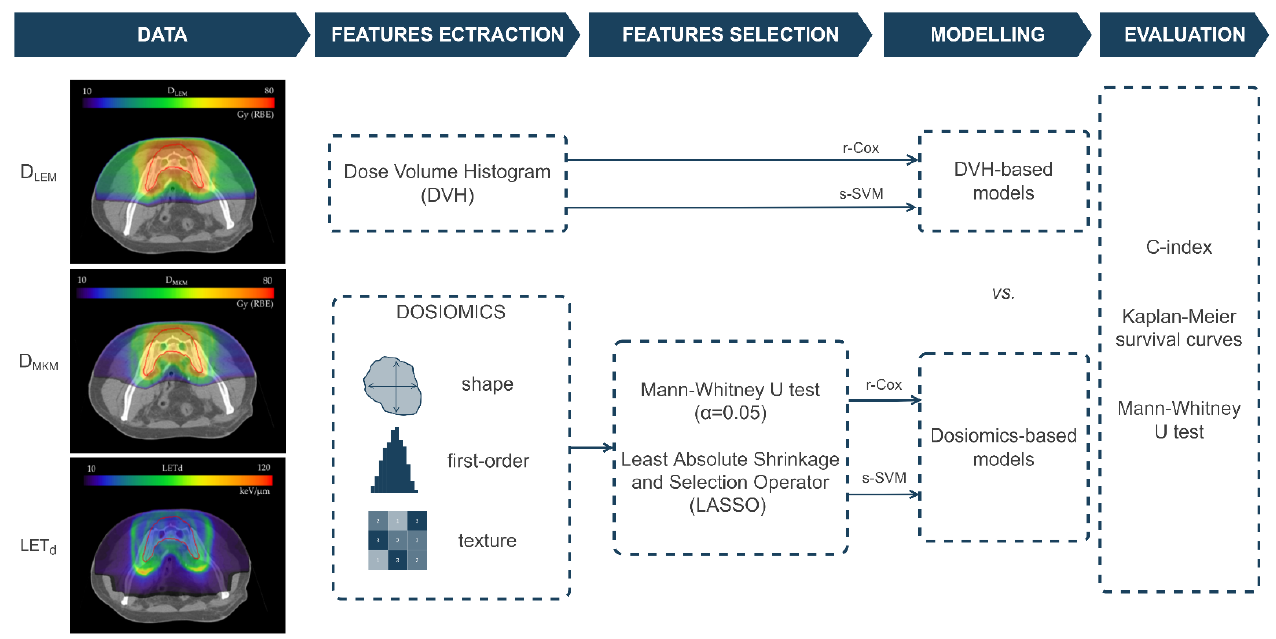
Figure 1. The proposed workflow. Dosimetric parameters and dosiomics features were extracted from D LEM , D MKM and LET d maps. Mann – Whitney U test (MW) and Least Absolute Shrinkage and Selection Operator (LASSO) were used as selection routines for dosiomics features. Survival models based on r-Cox and s-SVM were both used to build DVH-based and dosiomics-based models for LR and HD-LR prediction. A stratified 5-fold cross-validation was performed to evaluate the models through C-index, Kaplan – Meier survival curves and Mann – Whitney U